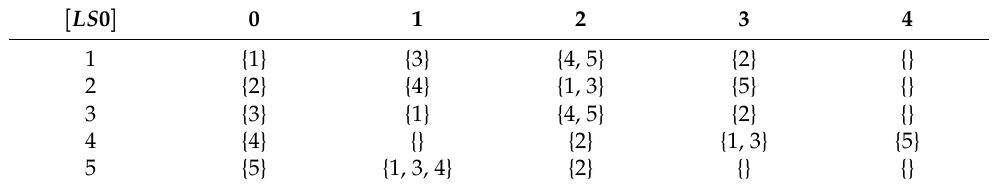
Table 3. Szeged layers ( LS 0 i , k ← { j | Szd i , j = k } ) for Figure 1.